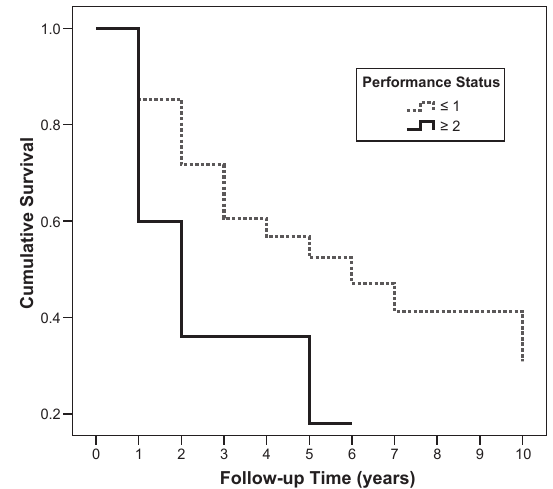
Figure 2 - Mortality and Kaplan-Meier curves with univari- ate significance determined by the log-rank test, age predic- tor, for subjects with DLBCL of the OC-MR, seen at the A.C.